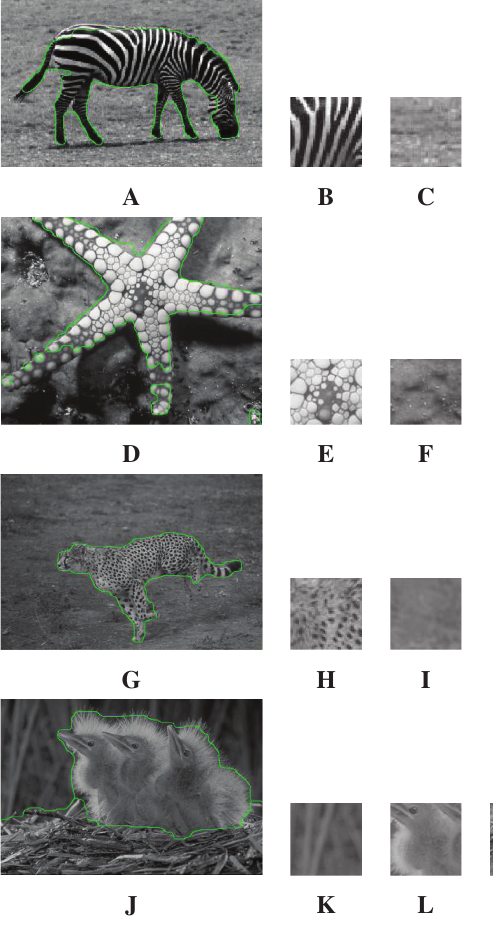
Figure 3. Texture Segmentation on Natural Images: (A, D, G, J) Segmentation for the Z ebra , S tarfish , Birds , Cheetah Images, Respectively. (B, C,) (E, F) (H, I) (K, L, M) Training Patches from the Classes in the Corresponding